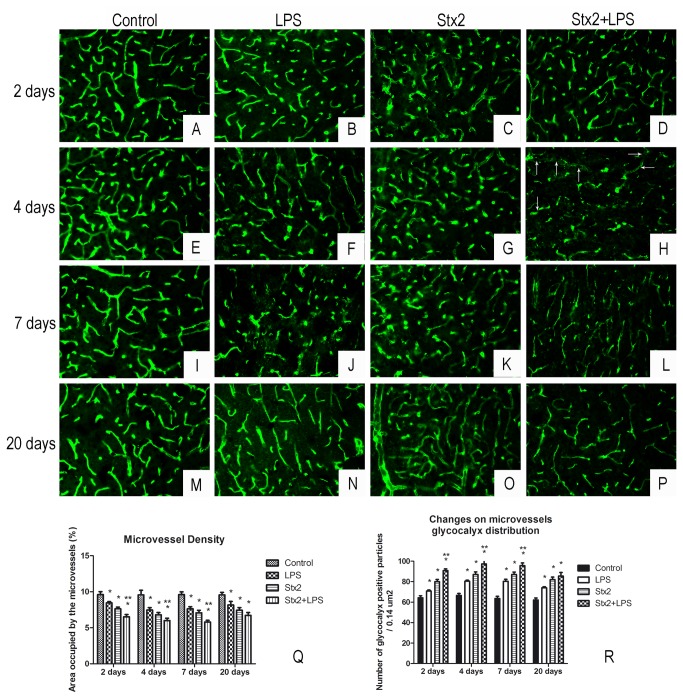
Changes in the expression of glycocalyx particles bound to fluorescent lectins in the cerebral microvasculature of mice motor cortex.Micrographs A, E, I and M show the microvasculature profile in the control groups; B, F, J and N: LPS treatment; C, G, K and O: Stx2 treatment; D, H, L and P: Stx2+LPS treatment; at two, four, seven and twenty days after the respective treatment. Arrows (H) show microvessels devoid of glycocalyx particles bound to fluorescent lectins. Stx2+LPS decreased microvessel density (Q) and increased the number of positive glycocalyx particles (R). *: significant differences between treated and control groups; **: significant differences between Stx2 and Stx2+LPS treatments (p <0.001).